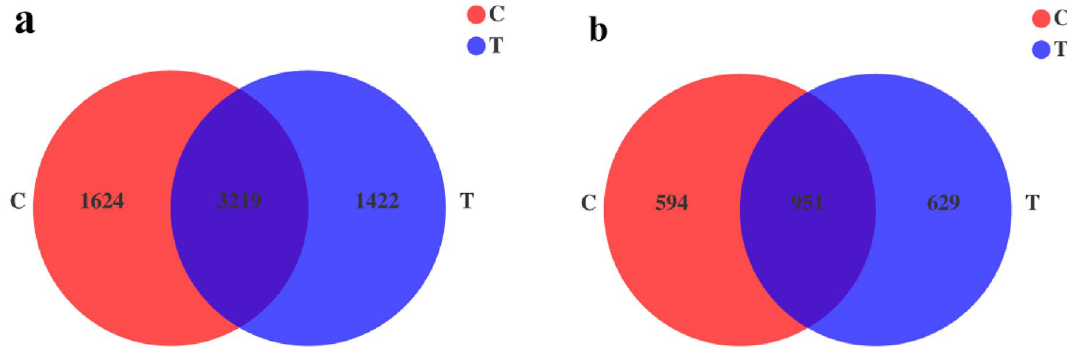
Figure 2. A Venn diagram shows the number of unique, shared, and common operational taxonomic units. ( a ) bacterial, ( b ) fungal.